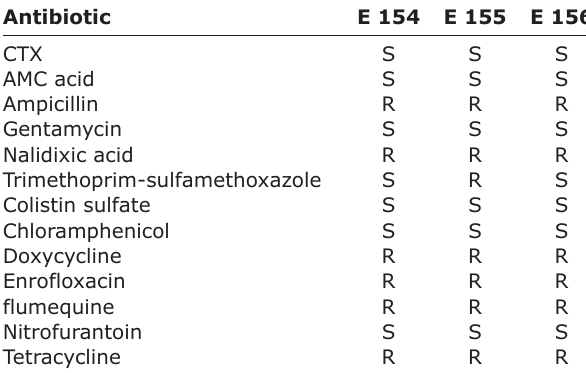
Table-4: Resistance and sensitivity of the three strains with ESBL.